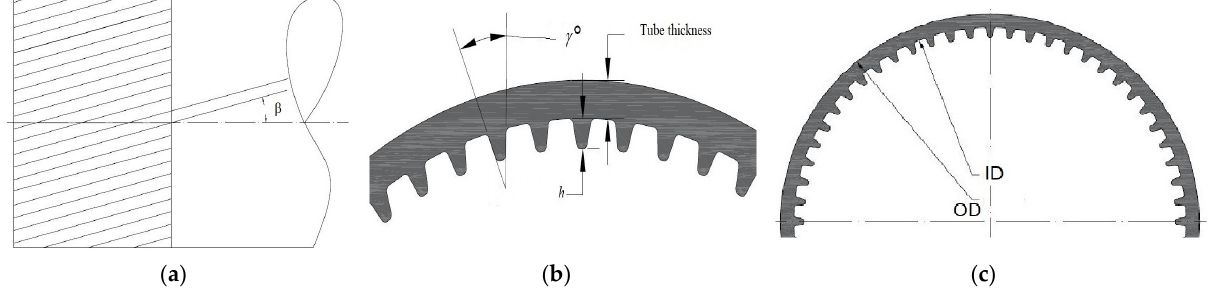
Table 2. Summary of experiments on flow boiling heat transfer of pure and mixed refrigerants in micro-finned tubes.